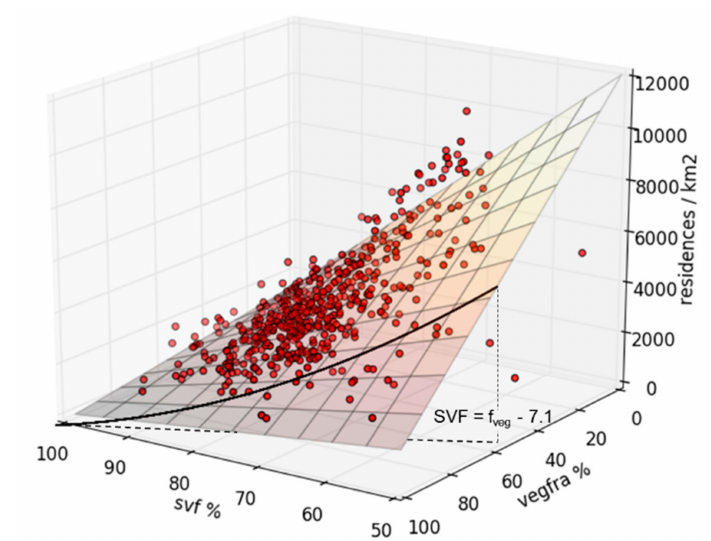
Figure 4. Empirical relationship among the density of the residences [27], the sky-view factor (SVF), and the vegetation fraction for the agglomeration of The Hague presented on a three-dimensional (3D) surface (R 2 = 0.64). Areas with more than one-third non-residential buildings were removed from the analysis. Areas with a population density below 750 per km 2 were also removed. The black line and the black dotted line indicate the equilibrium between the slopes of the vegetation fraction and the